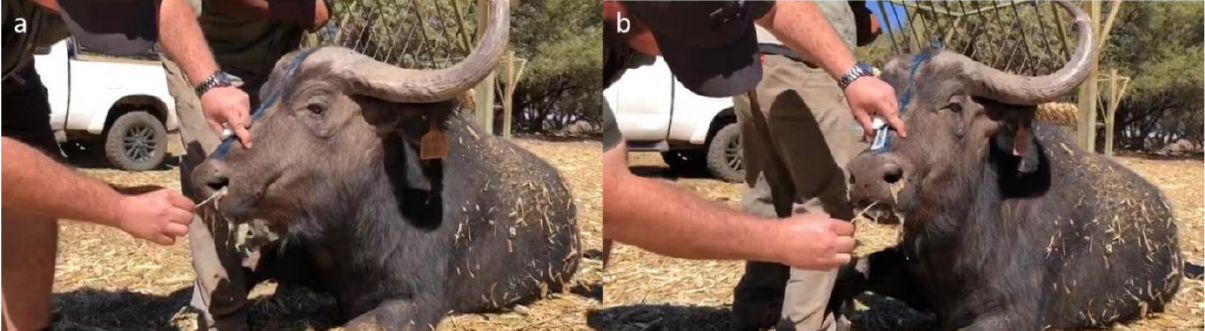
Figure 2. Collection of oronasal secretions from immobilised African buffaloes using swabs. ( a ) Swab collection of nasal secretions; ( b ) Swab collection from the mouth using the same swab as in ( a ).